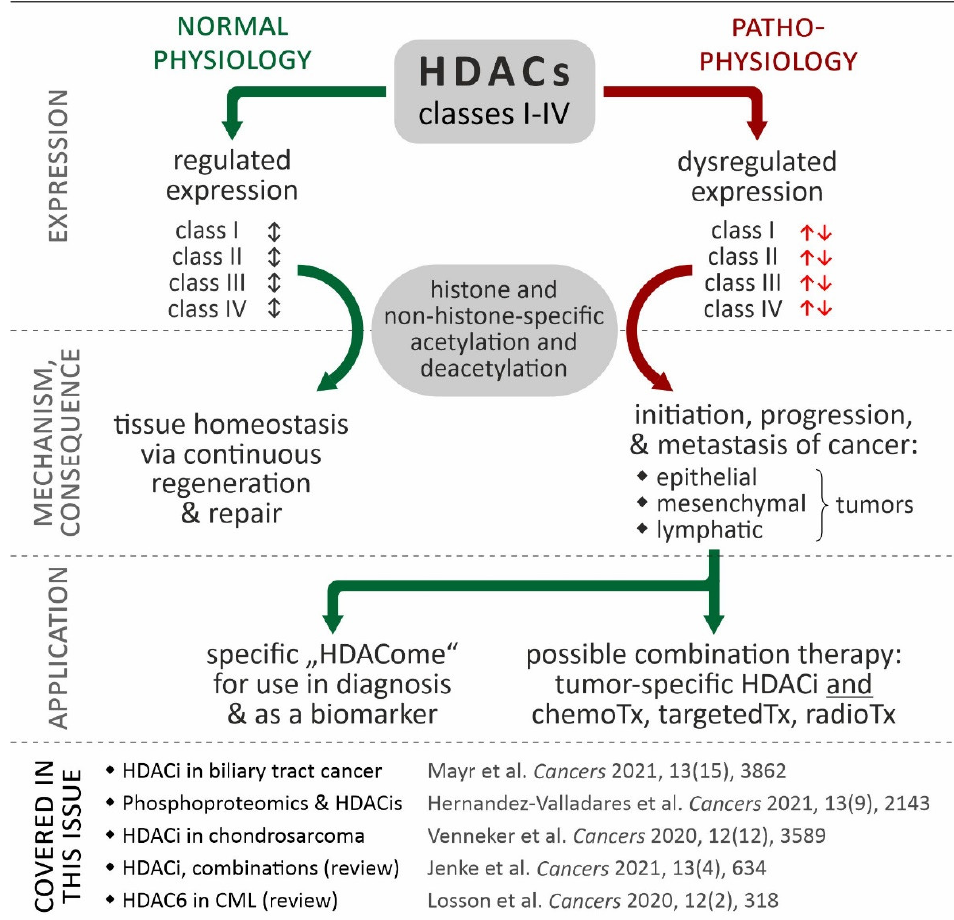
Figure 1. Relevance of HDACs in cancer. While coordinated in normal physiological processes (black double arrows), in many cancers, HDAC isoforms show de-regulated expression contributing to the hallmarks of cancer (red arrows). Based in this data, the “HDACome” on individual cancer types could be used for diagnosis (e.g., biomarker) or be exploited in tumor-specific combination of HDACi and other therapies. The references provided in the figure refer to articles in the special issue “Targeting Histone Deacetylases in Cancer” (Cancers, https://www.mdpi.com/journal/can-